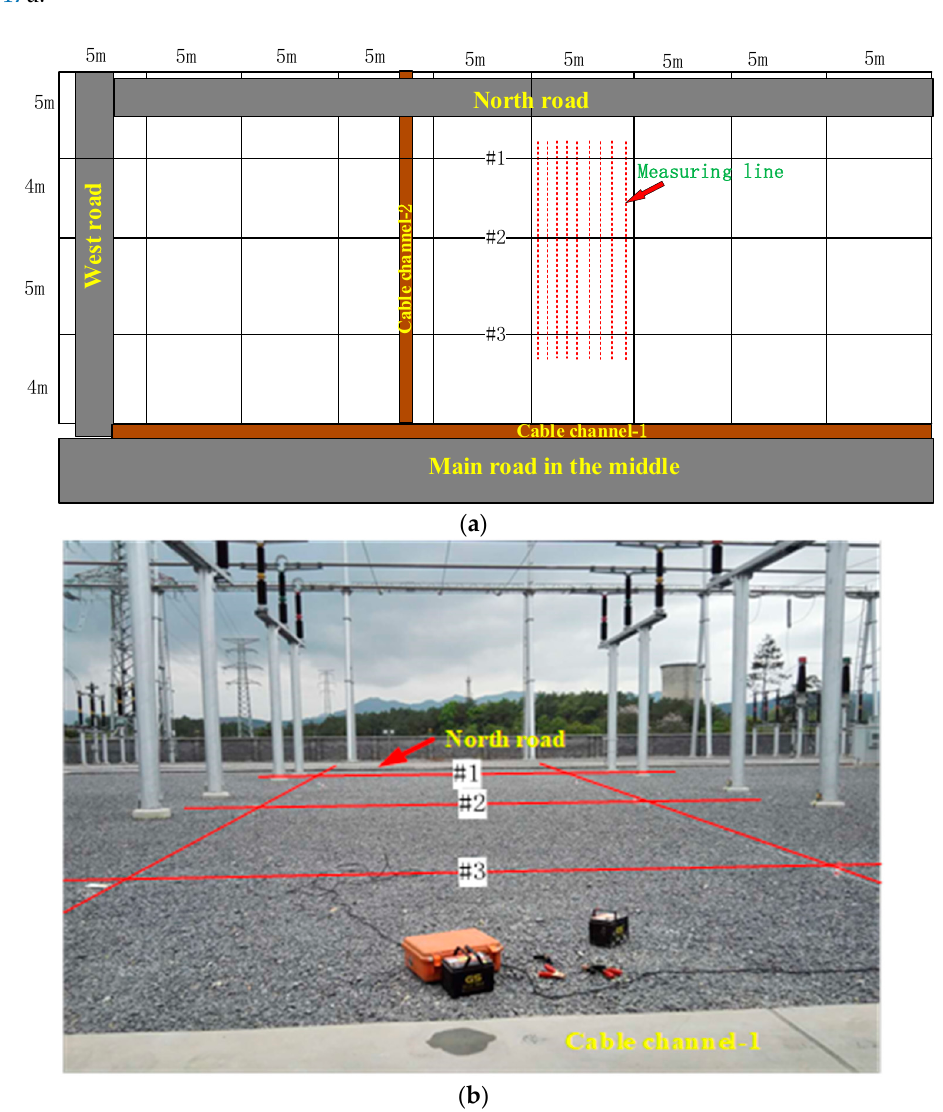
Figure 17. The Chongqing Hongqiang 220 kV substation. ( a ) Topological structure of the grounding grid. ( b ) The experiment site and test field measurement